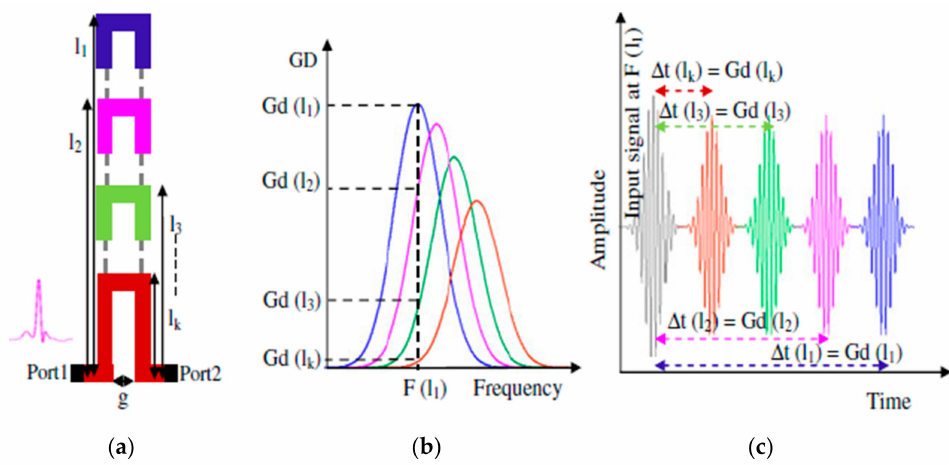
Figure 8. Principle of encoding by means of group delay: ( a ) structure of the chipless-RFID tag; ( b ) group delay vs. frequency for di ff erent lengths of C-sections, and ( c ) the corresponding time domain response. Figure extracted from [34].